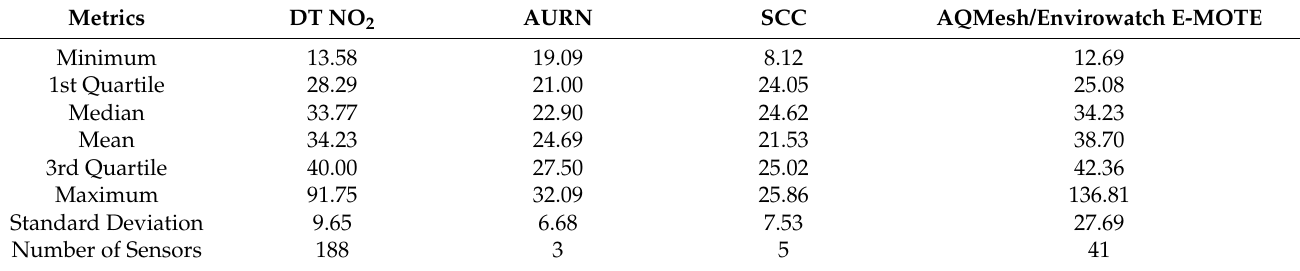
Table 1. Summary of annual mean NO 2 concentrations ( µ g/m 3 ) measured by diffusion tubes (DT), automatic urban and rural network (AURN), Sheffield City Council (SCC) and low-cost sensors (LCS) (AQMesh and Envirowatch) in